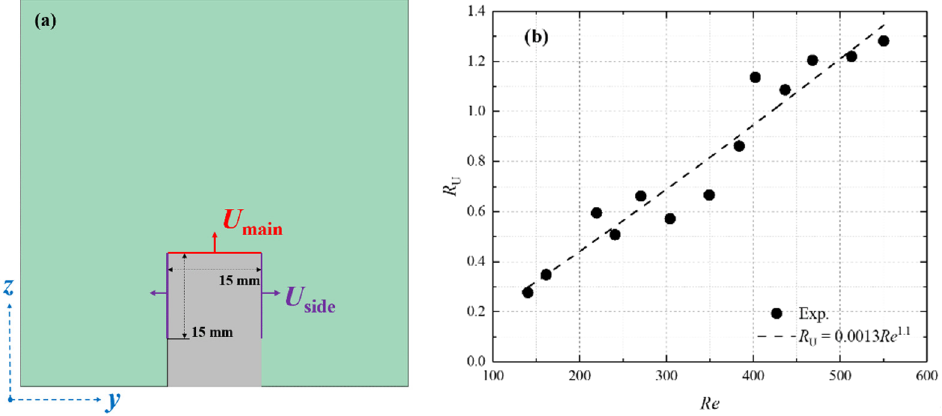
Figure 5. Relation between R U ( U main / U side ) and Re : ( a ) definition of U main and U side , ( b ) variation of R U against Re.